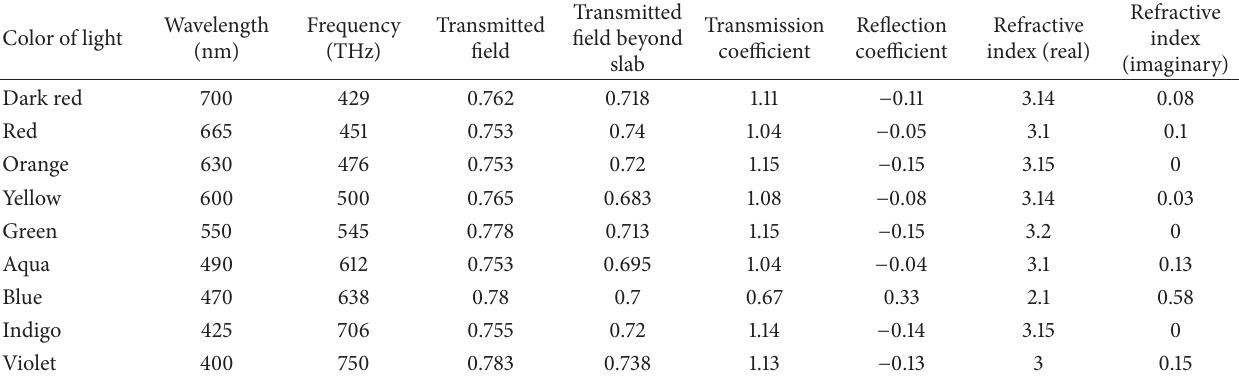
Table 4: Variations in different parameters of an optical cloaking system for a radius ratio of